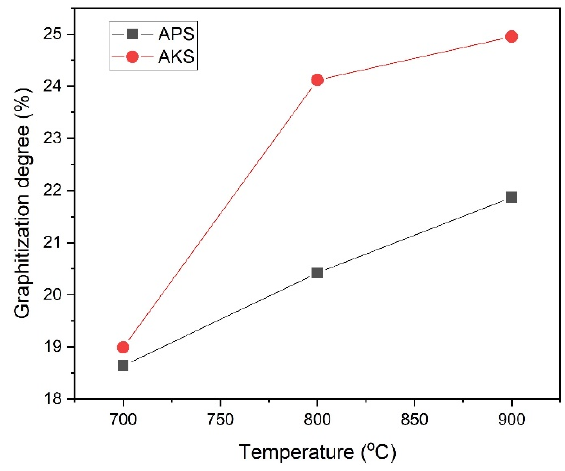
Figure 3. Dependence of graphitization degree from temperature.